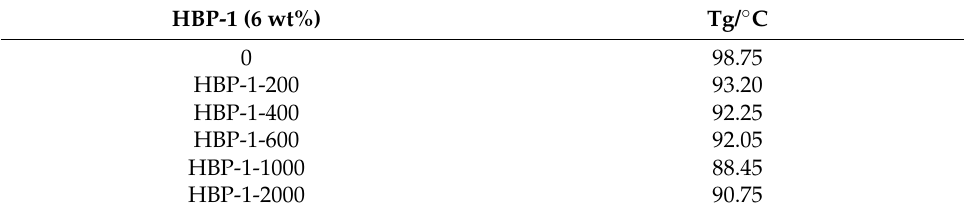
Table 3. Glass transition temperature (Tg) of the neat UPR and the UPR